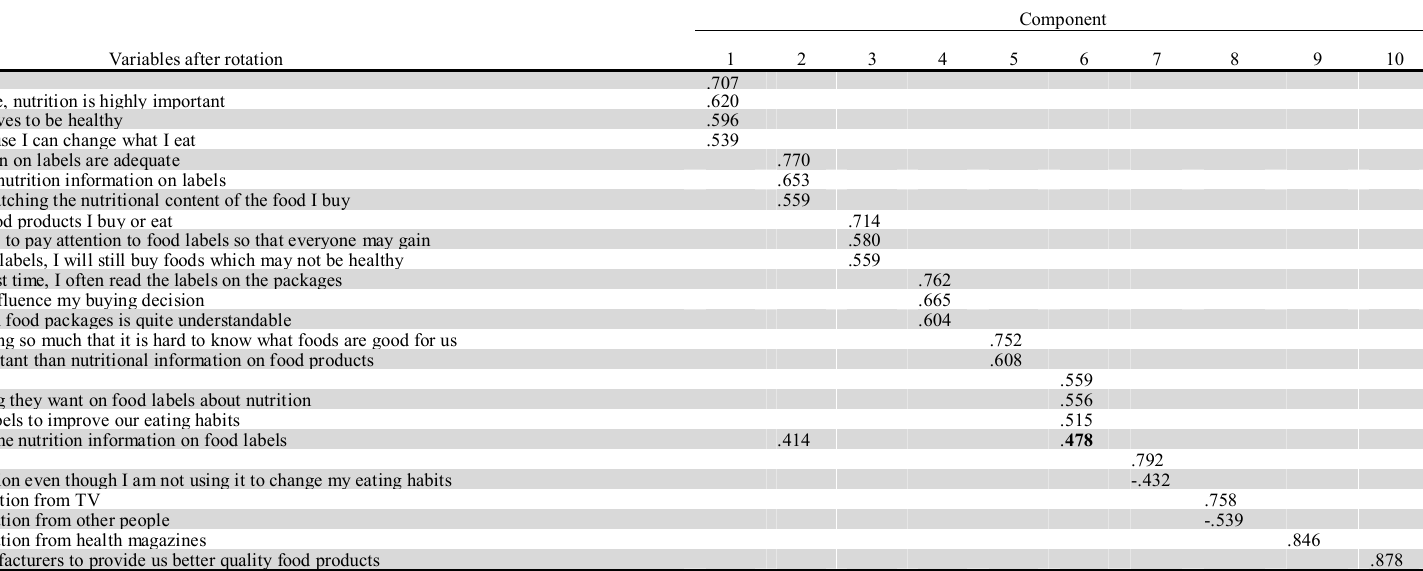
Rotated Component Matrix